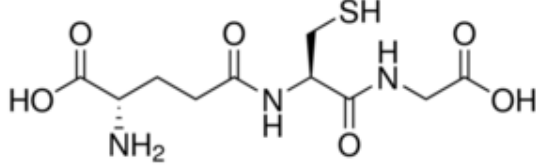
Figure 6. Structure of L-glutathione.